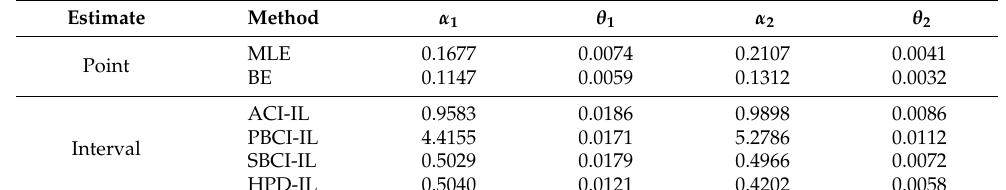
Table 17. Parameter estimates for the real dataset.